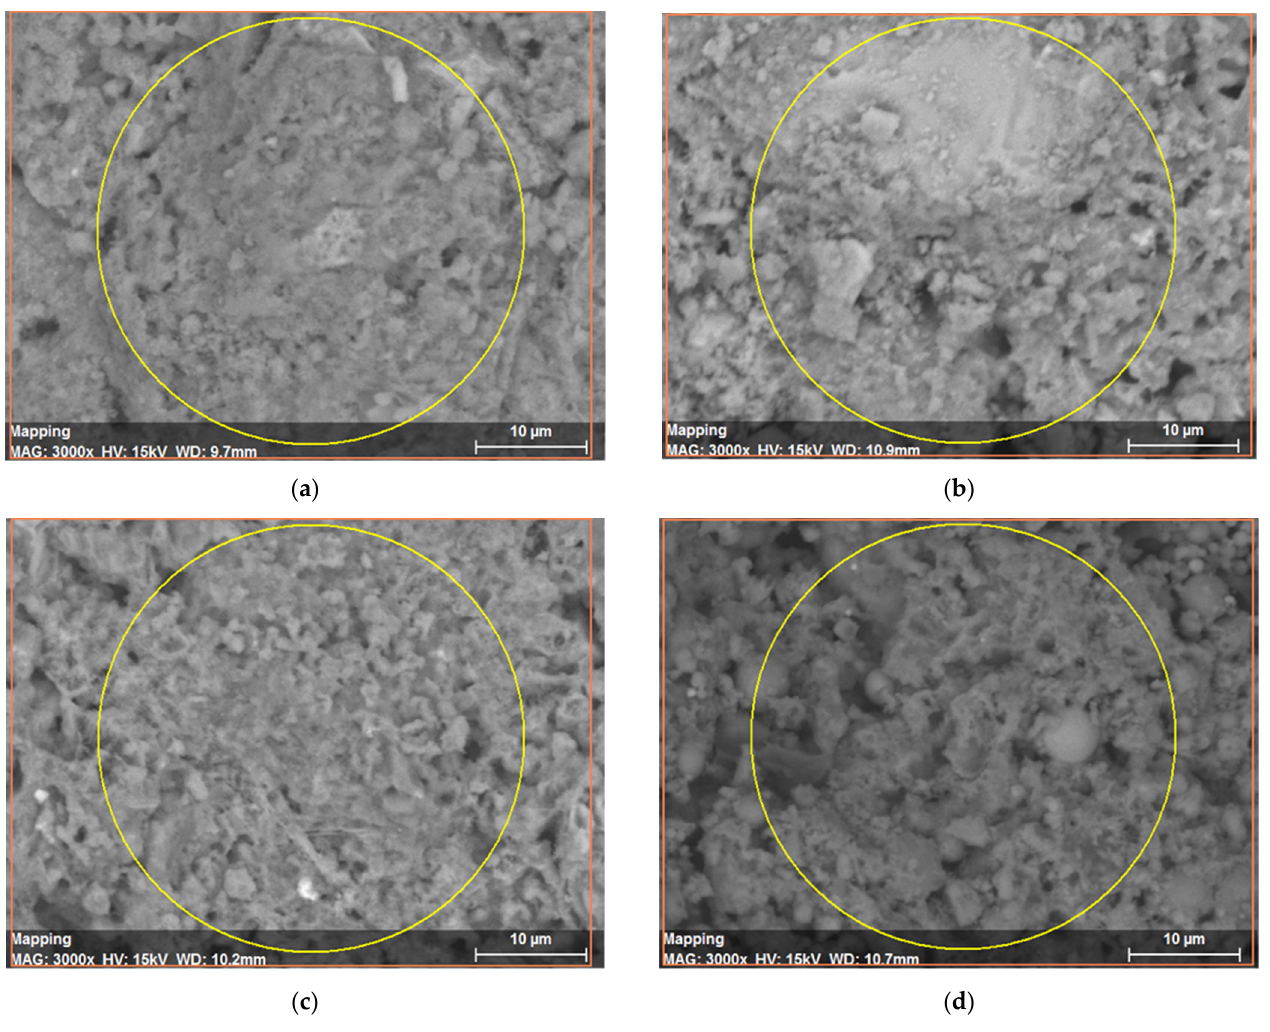
Figure 8. SEM images of the mortar samples with different substitution materials. ( a ) BMA 5%; ( b ) SBA 5%; ( c ) CA 5%; ( d ) BFS